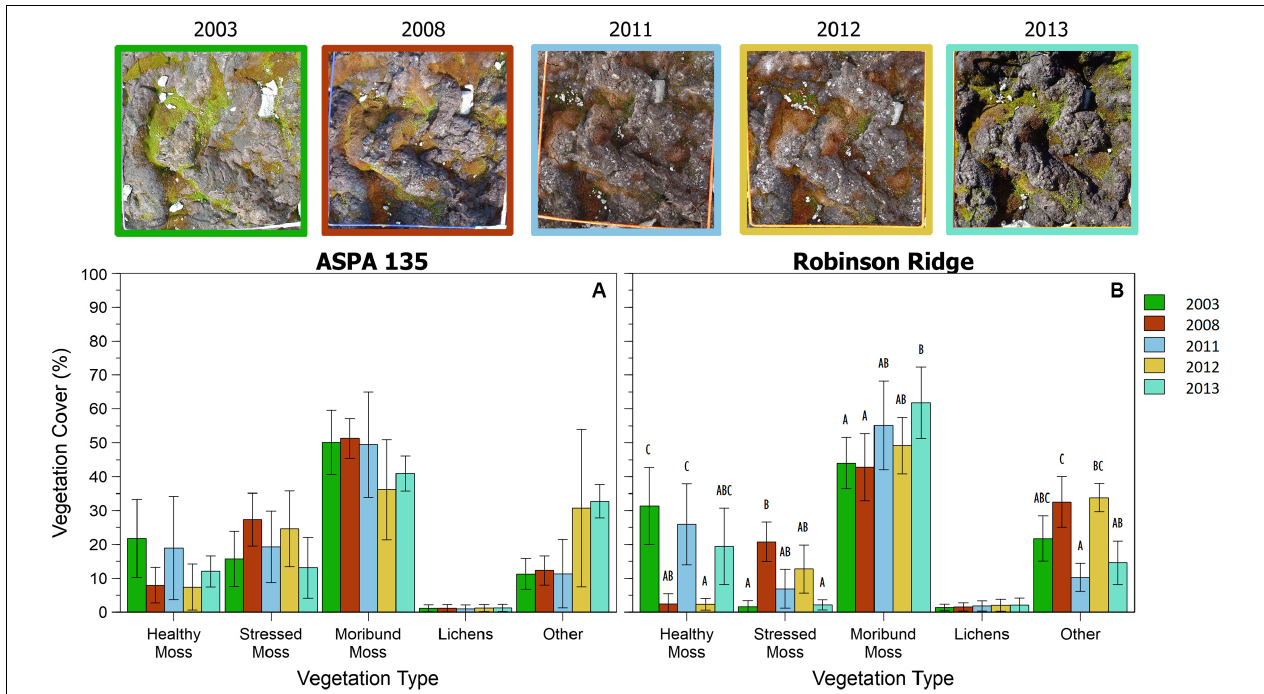
FIGURE 7 | Trends in Transitional community vegetation cover from 2003 to 2013 at two sites in the Windmill Islands, A2 (A) and RR (B) . Photographs depict a representative quadrat (site A2, quadrat T2) at each of the five time points. NB: Transitional communities were not monitored in 2014. Data are mean percent cover of vegetation ± 95% CI. Different letters denote significant differences between years per vegetation